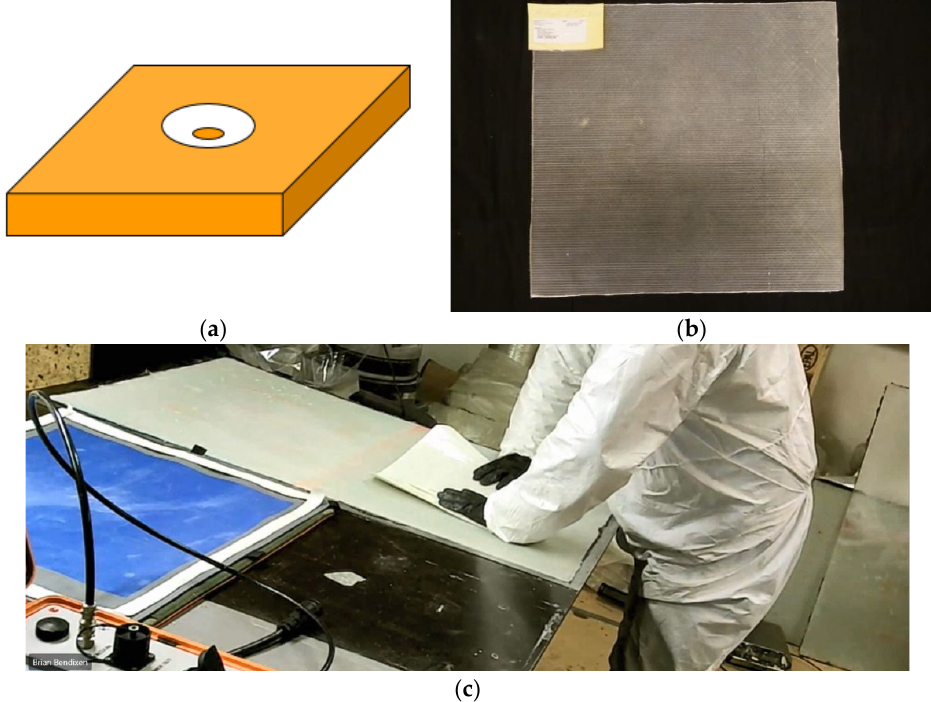
Figure 1. Schema of damaged plate ( a ), photos of plate ( b ) and of repair procedure ( c ). In the experiments, six different repair technologies were used,